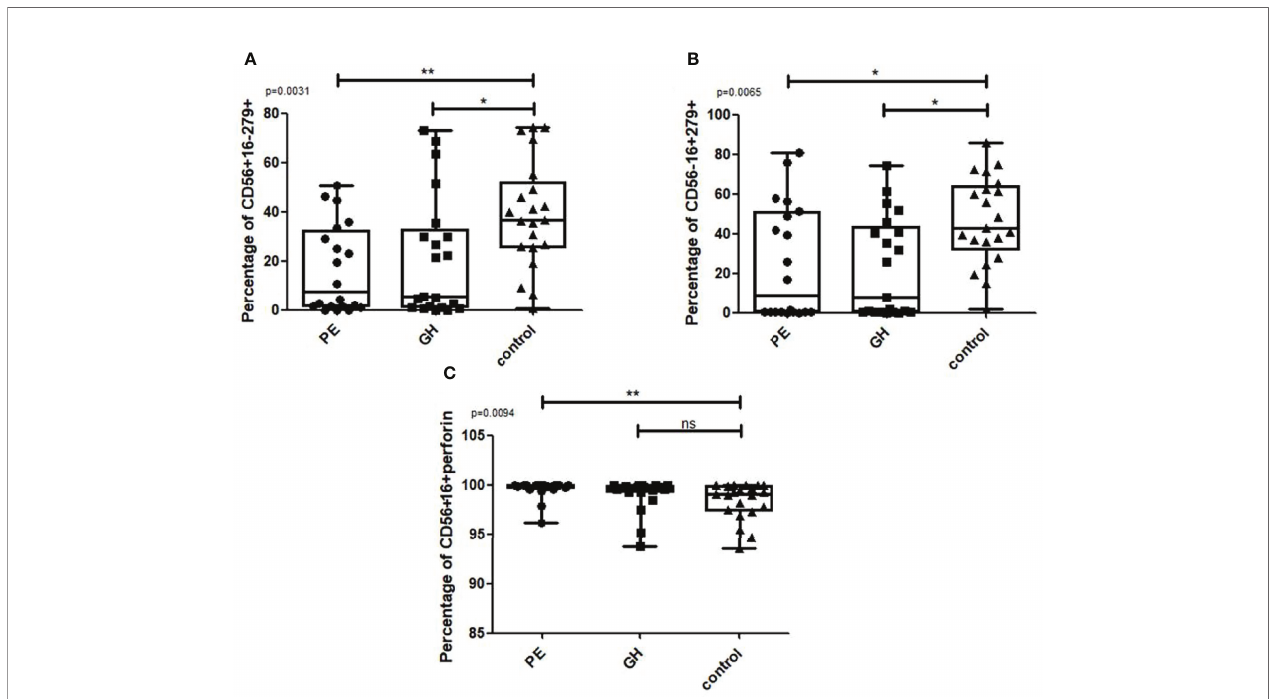
FIGURE 8 | Box and whiskers graphs show differences when the HDP group is divided into PE and GH. Statistics performed with the Kruskal Wallis test, p<0.05 is considered signi fi cant. *p<0.05; **p<0.01, ns- not signi fi